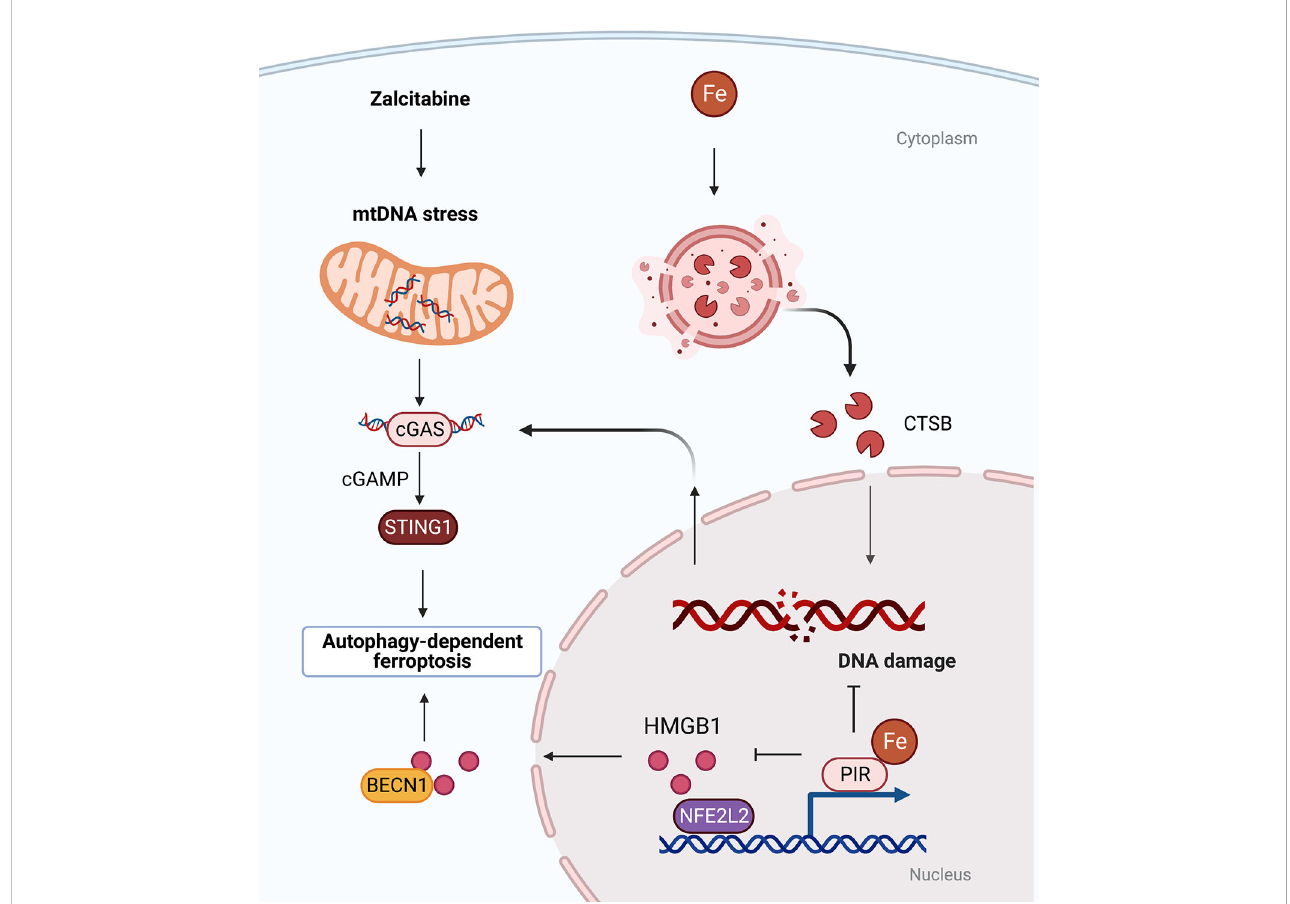
FIGURE 2 Organelle-speci fi c initiation of autophagy-dependent ferroptosis. There is crosstalk between lysosomes, nucleus and mitochondria. Oxidative damage to nuclear or mitochondrial DNA triggered by iron-dependent CTSB translocation or anti-HIV drug zalcitabine can activate STING-dependent autophagy and ferroptosis. BECN1, beclin 1; cGAS, cyclic GMP-AMP synthase; CTSB, cathepsin B; HMGB1, high mobility group box 1; PIR, pirin; STING1, stimulator of interferon response cGAMP interactor